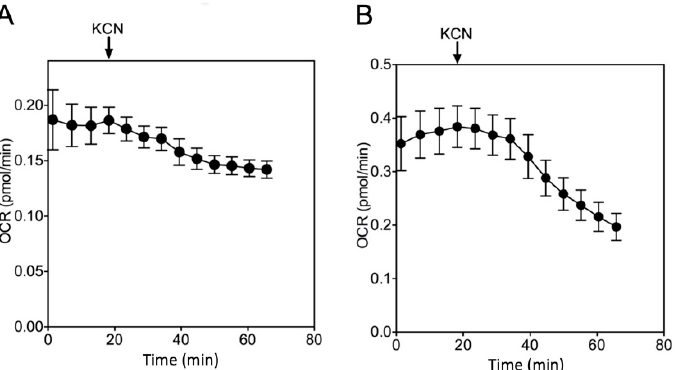
Figure A3. Oxygen (O 2 ) consumption measurements in cardiac left ventricle samples ( A ) or in lung samples ( B ). Oxygen consumption rate (OCR, pmol/min/µg protein) were quantified in both tissues with XF24 Seahorse. KCN (100 mM) was injected at the indicated time (arrow) in order to progressively inhibit mitochondrial respiration (grey). OCR has been assessed from duplicate biopsies of three mice for each condition ( n =